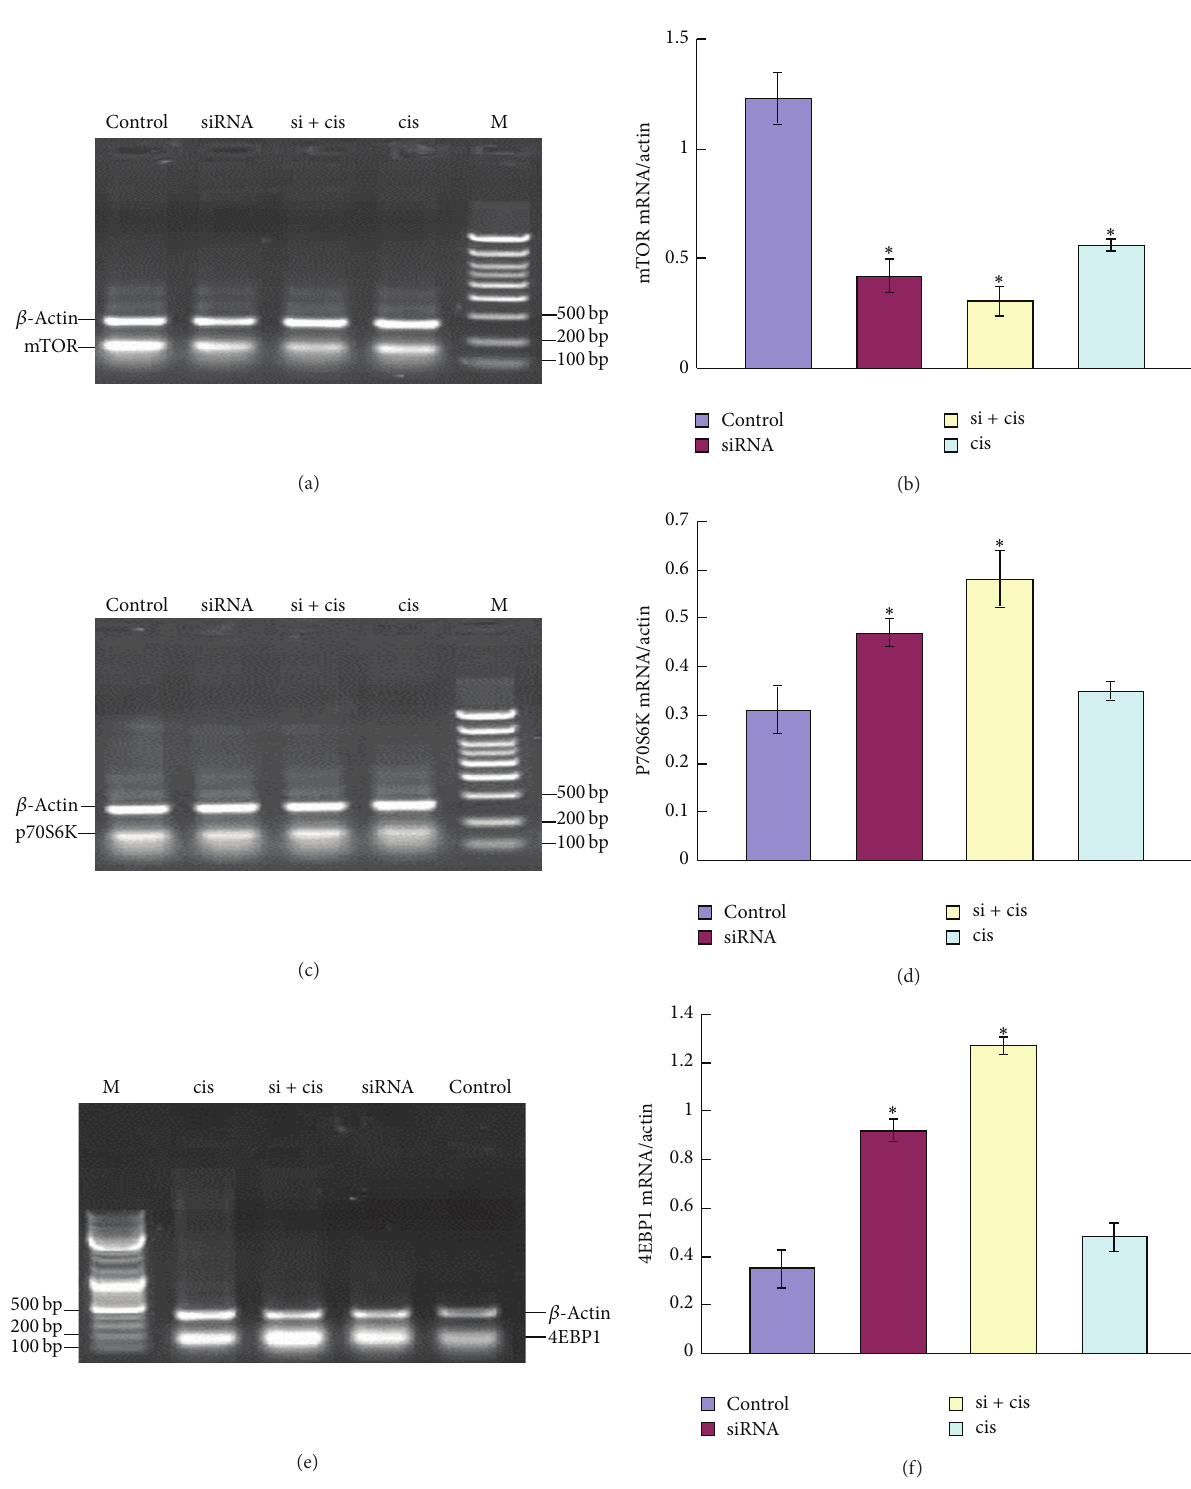
Figure 5: Analysis of total mRNA expressions of mTOR (a), p70S6K (b), and 4EBP1 (c) from EC9706 xenografts treated by different ways. ((d)–(f)) Semiquantitative values of mRNA levels of mTOR, p70S6K, and 4EBP1 to 𝛽 -actin, respectively. Results from three independently repeated experiments, which were statistically analyzed by densitometry using BandScan 5.0 software, are expressed as means ± SD. The mRNA level of mTOR was downregulated while mRNA levels of p70S6K and 4EBP1 were upregulated after being treated with mTOR siRNA and siRNA + cisplatin. ∗ 𝑃 < 0.05 , compared to control